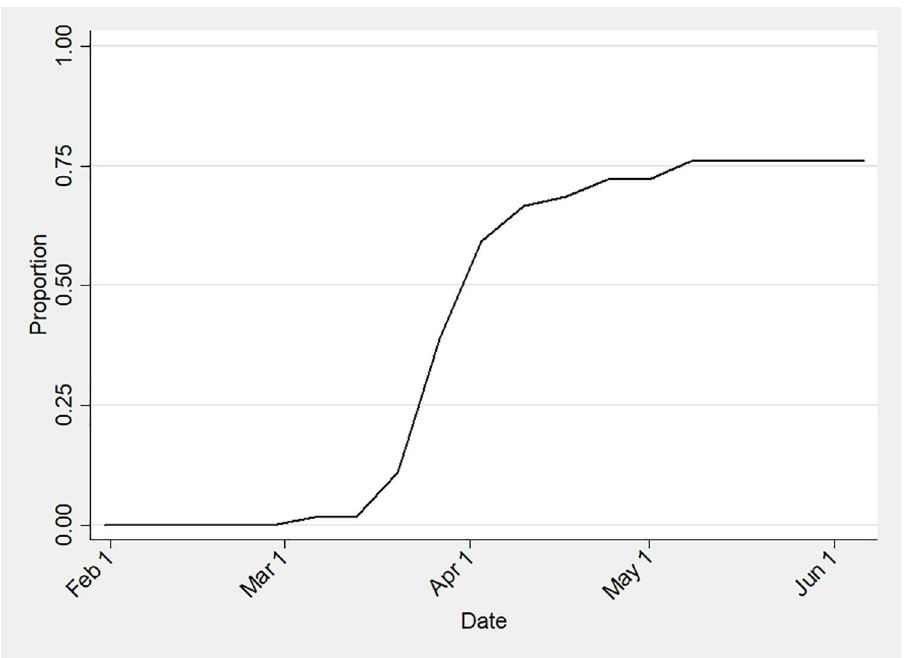
Fig 3. Cumulative distribution of SAHOs by